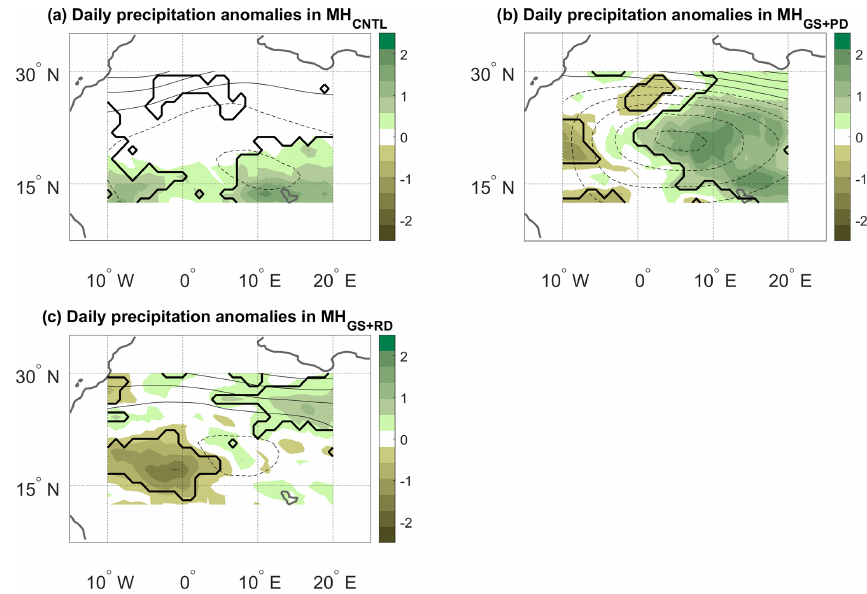
Figure 7. JJAS precipitation (colours, mmd − 1 ) and Z500 (contours, m) anomalies on days with high α (see text) for the (a) MH CNTL , (b) MH GS+PD and (c) MH GS+RD simulations. The contour lines have an interval of 20m and span the following ranges: (a) + 40 to − 40m, (b) + 60 to − 100m and (c) + 60 to − 20m. Continuous contours show zero and positive anomalies, and dashed contours show negative anomalies. The anomalies are only shown over the domain used to perform the dynamical systems analysis (see the black box in Fig. 2a). Bold lines mark significance bounds for precipitation (see